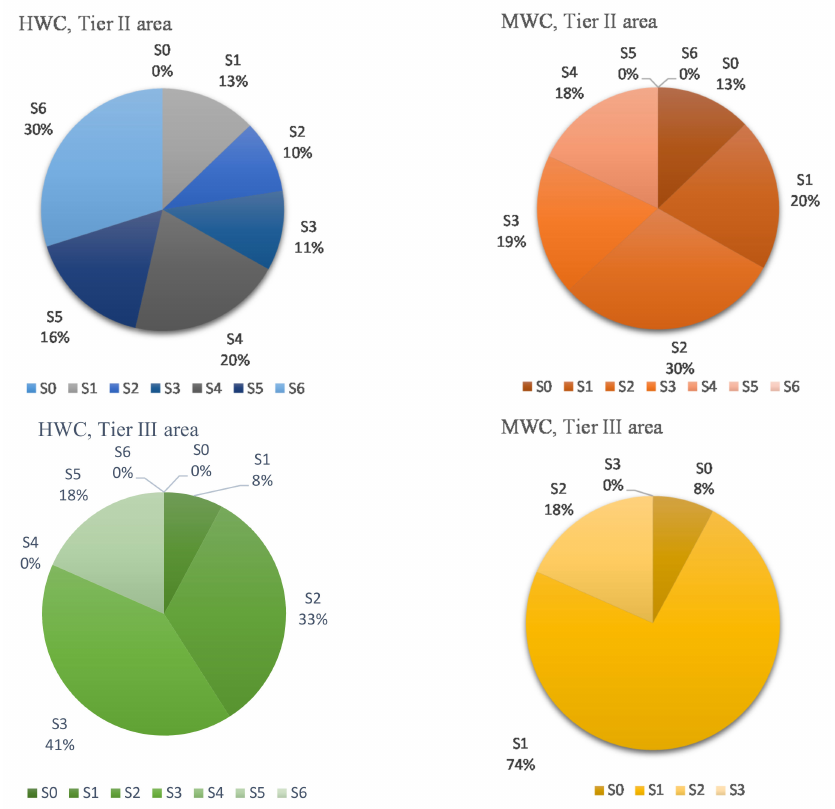
Figure 18. Prevailing sea states in moderate and harsh weather conditions within parts of the sailing route subjecting to Tier II and Tier III